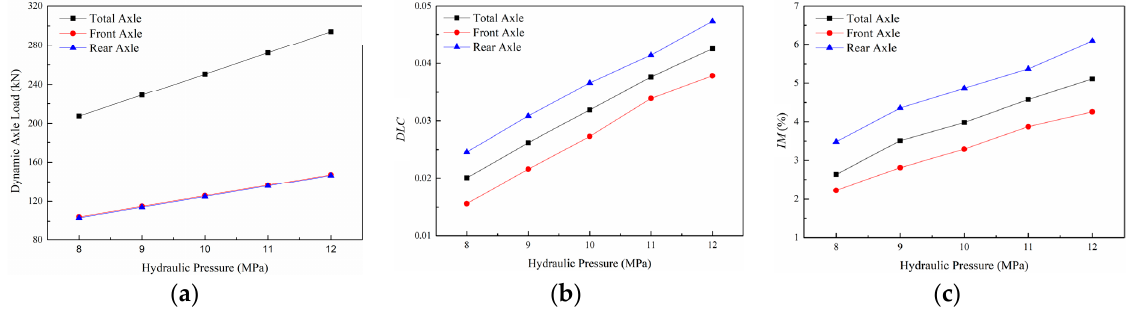
Figure 18. Dynamic axle load in straight road sections with different hydraulic pressure under simulation conditions. ( a ) Dynamic axle load. ( b ) DLC . ( c ) IM .